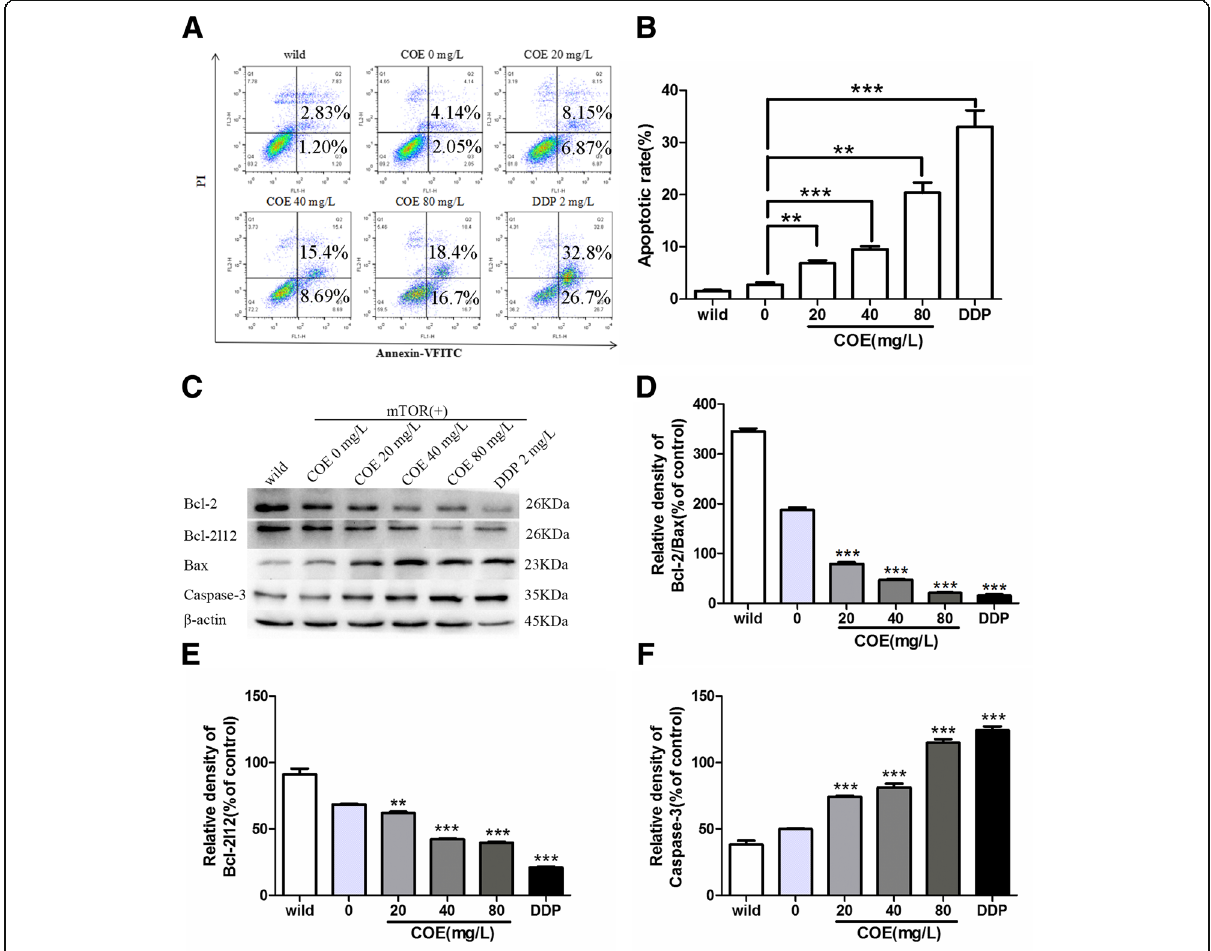
Fig. 4 COE promoted apoptosis of the HCC cells. The HepG2/mTOR + cells were treated with 0.1%DMSO as solvent control, or 2 mg/L DDP, or different concentrations of COE (20, 40, 80 mg/L) for 24 h. a and b the apoptosis was detected by Flow cytometry. c - f the protein expression of Bcl-2, Bcl-2 L12, Bax, and Caspase-3 were examined by Western blots. ( ** P < 0.01, *** P < 0.001, compared with the